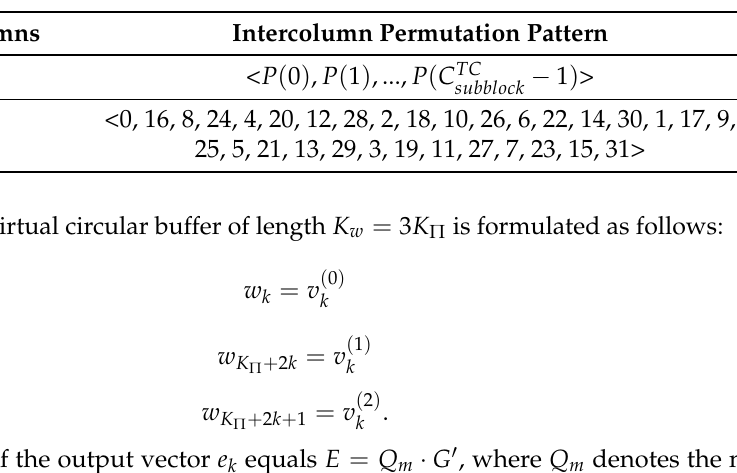
Table 1. Intercolumn permutation pattern for sub-block interleaver.